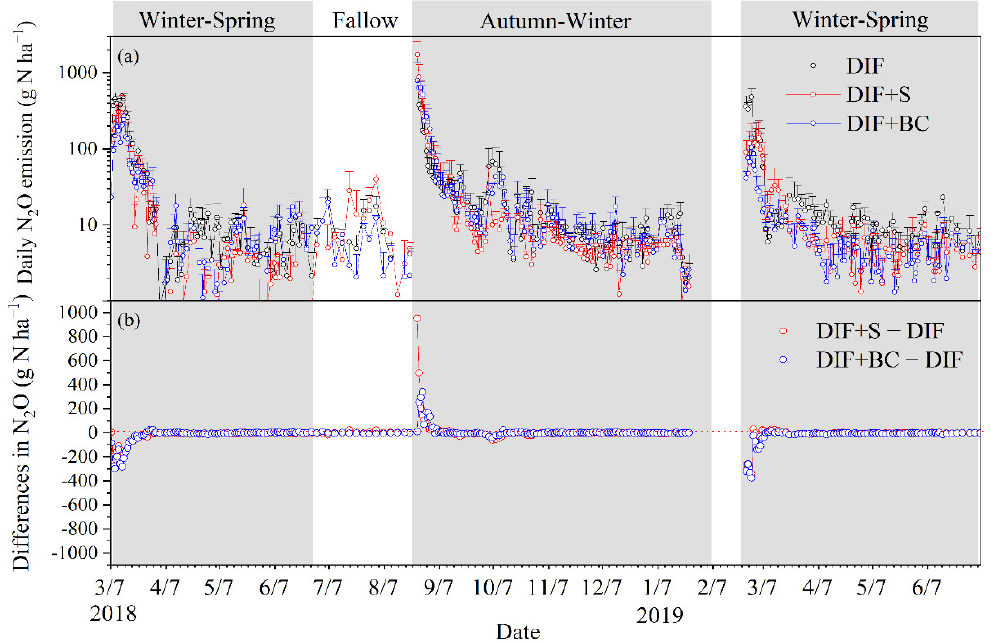
Figure 3. Daily fluxes of N 2 O emissions during three growing seasons for the three different treat- ments ( a ) and differences in daily N 2 O emissions between with and without straw or biochar incorporation ( b ). DIF: drip fertigation; DIF+S: drip fertigation with straw incorporation; DIF+BC: drip fertigation with biochar incorporation. DIF+S − DIF and DIF+BC − DIF means the differences between with and without S or BC incorporation. Error bars represent the standard error ( n =